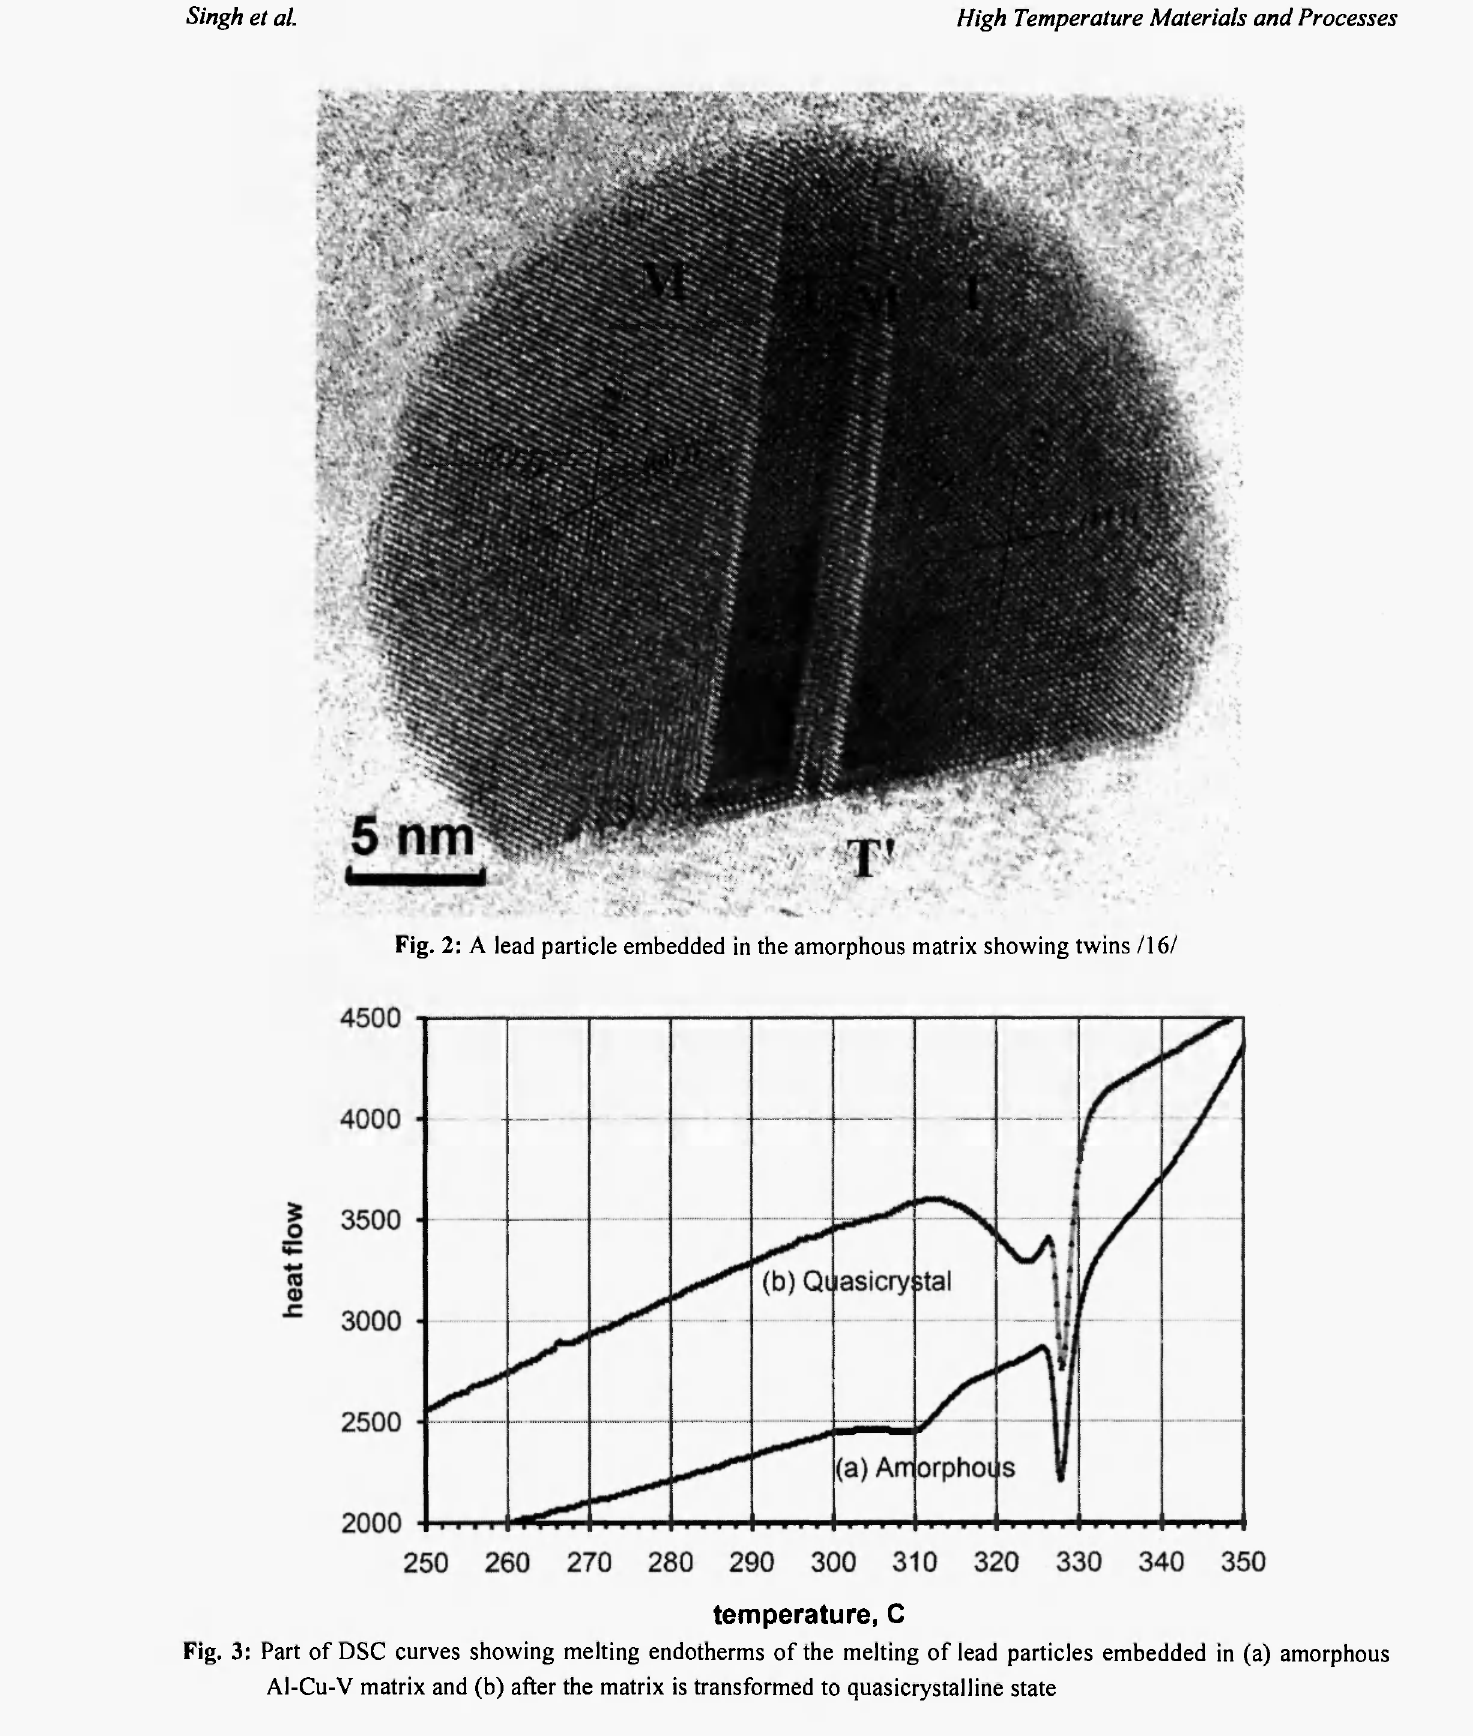
temperature, C Fig. 3: Part of DSC curves showing melting endotherms of the melting of lead particles embedded in (a) amorphous Al-Cu-V matrix and (b) after the matrix is transformed to quasicrystalline state